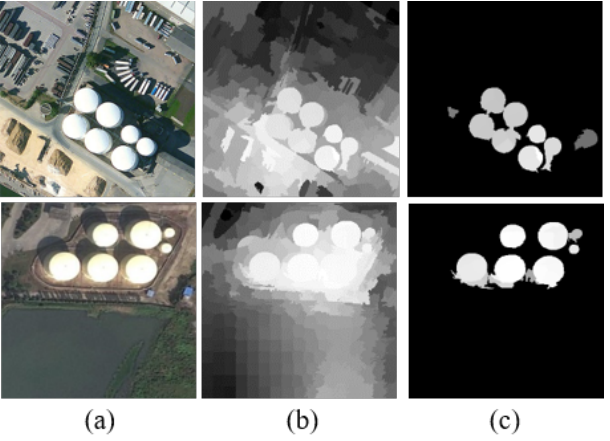
Figure 3. ( a ) is the input image, ( b ) is the result of Color Markov Chain, and ( c ) is the result after contrast